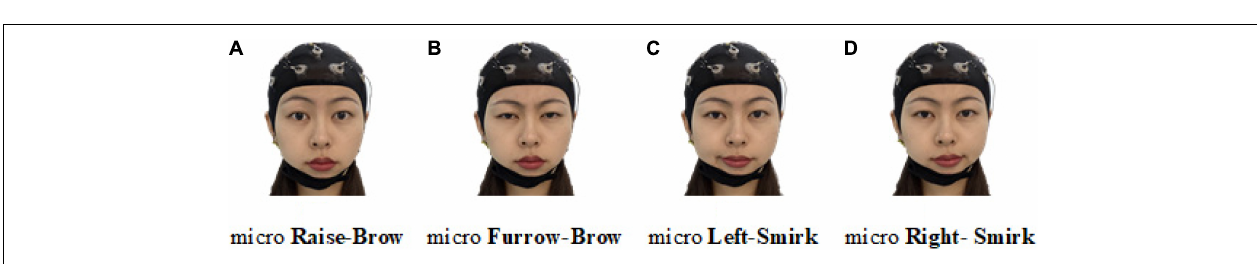
FIGURE 10 | Illustration of four selected microexpressions. (A) Micro raise-brow. (B) Micro furrow-brow. (C) Micro left-smirk. (D) Micro right-smirk.